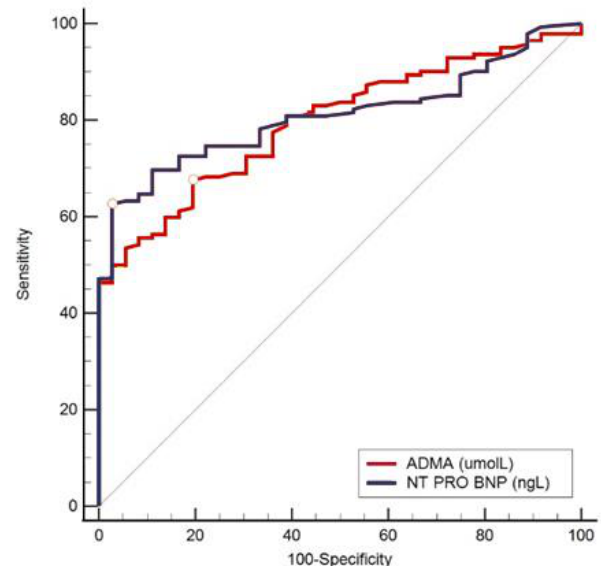
Figure 3. ROC curve comparing NT-proBNP and ADMA in different groups of subjects with LVDD grade 2 and LVDD grade 3. NT-proBNP again proved to be a significant parameter in differentiating LVDD grade 2 from LVDD grade 3 (AUC 0.904, 95% CI 0.844 – 0.964, sensitivity 81%, specificity 87%, cut-off values > 784 ng/L, Youden index 0.68, p < 0.001), while ADMA did not show statistical significance in differentiating LVDD grades 2 and 3 (AUC 0.582, 95% CI 0.461 – 0.703, sensitivity 67%, specificity 54%, cut-off values > 0.24 µmol/L, Youden index 0.21, p = 0.18).